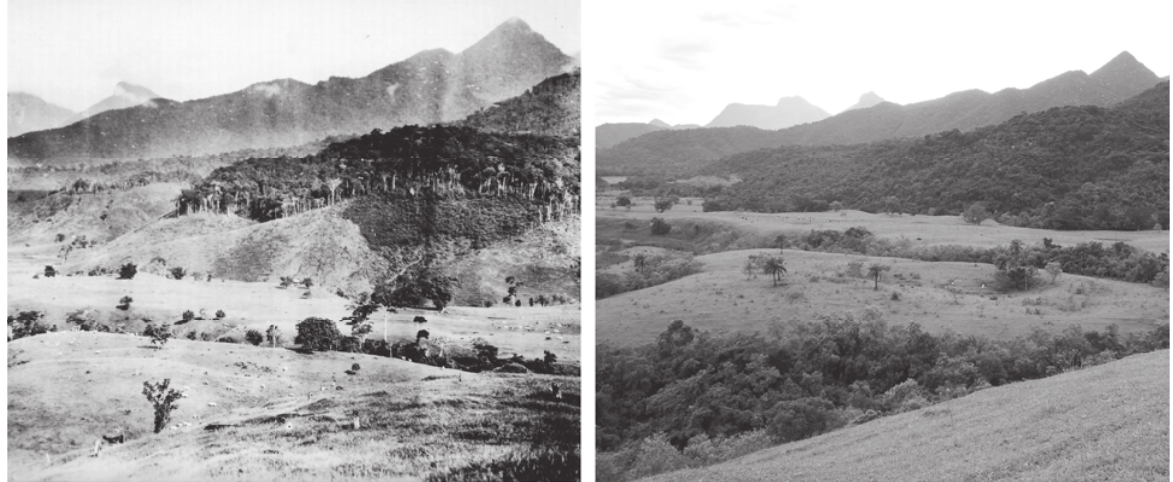
Figure 10 - Landscape in the foothills of the Serra dos Órgãos in the Guapiaçu catchment. Left: Situation in 1920 (Photo by H. Werner, 1920), right: 2010 (Photo by A. Kirchner). Clear visible is an increased forest cover in the lower